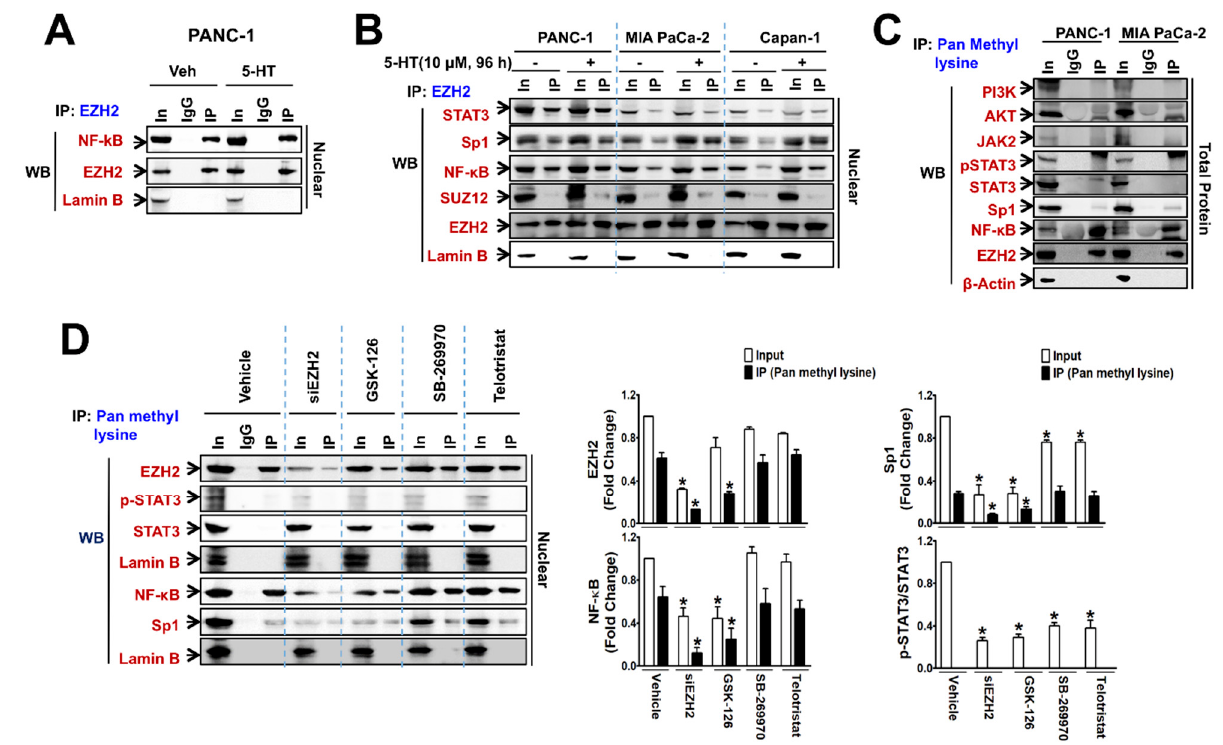
Figure 6. EZH2 binds to TFs, and methylates Sp1 and NF- κ B. Nuclear and total proteins extracted from PANC-1, MIA PaCa-2, and Capan-1 cells. For IP-immunoblotting data, antibodies used for co-immunoprecipitation (IP) and western blotting (WB) were labeled as blue and red, respectively. ( A ) Co-IP of NF- κ B and EZH2 in PANC-1 cells treated with 5-HT (10 μ M) for 96 h. IgG represents a control antibody used for IPs. The In represents input control. Prior to carrying out the IP experiments, cell lysates were subjected to the respective WB as input controls. ( B ) Co-IP of STAT3, Sp1, NF- κ B, SUZ12, and EZH2 in PANC-1, MIA PaCa-2, and Capan-1 cells treated with or without 5-HT (10 μ M) for 96 h. ( C ) Co-IP and immunoblot analysis of PI3K, AKT, JAK2, p-STAT3, STAT3, Sp1, NF- κ B, and EZH2 in PANC-1 and MIA PaCa-2 cells at basal level. ( D ) PANC-1 cells were treated with EZH2 siRNA (100 nM), GSK-126 (10 μ M), SB-269970 (3 μ M), or telotristat (3 μ M) for 48 h. Cell lysates were immunoprecipitated with pan methyl lysine antibody and immunoblotted with pSTAT3, STAT3, EZH2, Sp1, or NF- κ B antibody. The bar graphs represent the mean ± SEM of relative density of each protein from three independent experiments. * p < 0.05 compared to the vehicle-treated control group. The uncropped Western Blot images can be found in Figure S7.